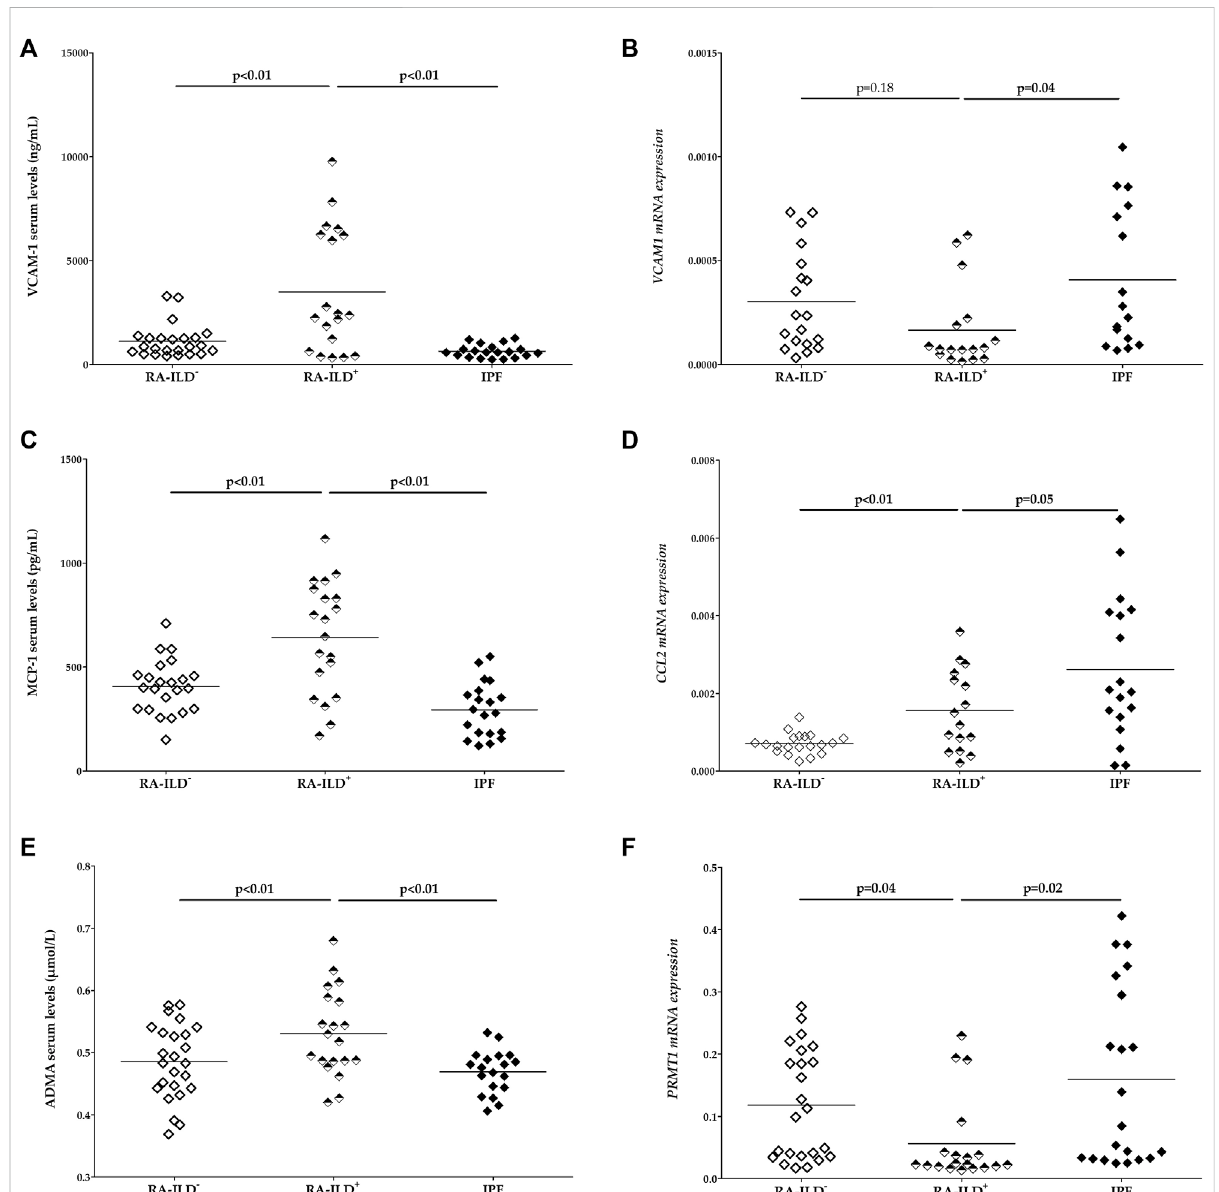
FIGURE 1 DifferencesinserumlevelsofVCAM-1 (A) ,MCP-1 (C) andADMA (E) aswellasmRNAexpressionof VCAM1 (B) , CCL2 (D) and PRMT1 (F) between RA-ILD + patients and the comparative groups. RA: rheumatoid arthritis; ILD, interstitial lung disease; IPF, idiopathic pulmonary fi brosis; VCAM-1, vascular cell adhesion molecule 1; MCP-1, monocyte chemoattractant protein-1; ADMA, asymmetric dimethylarginine. Signi fi cant results are highlighted in